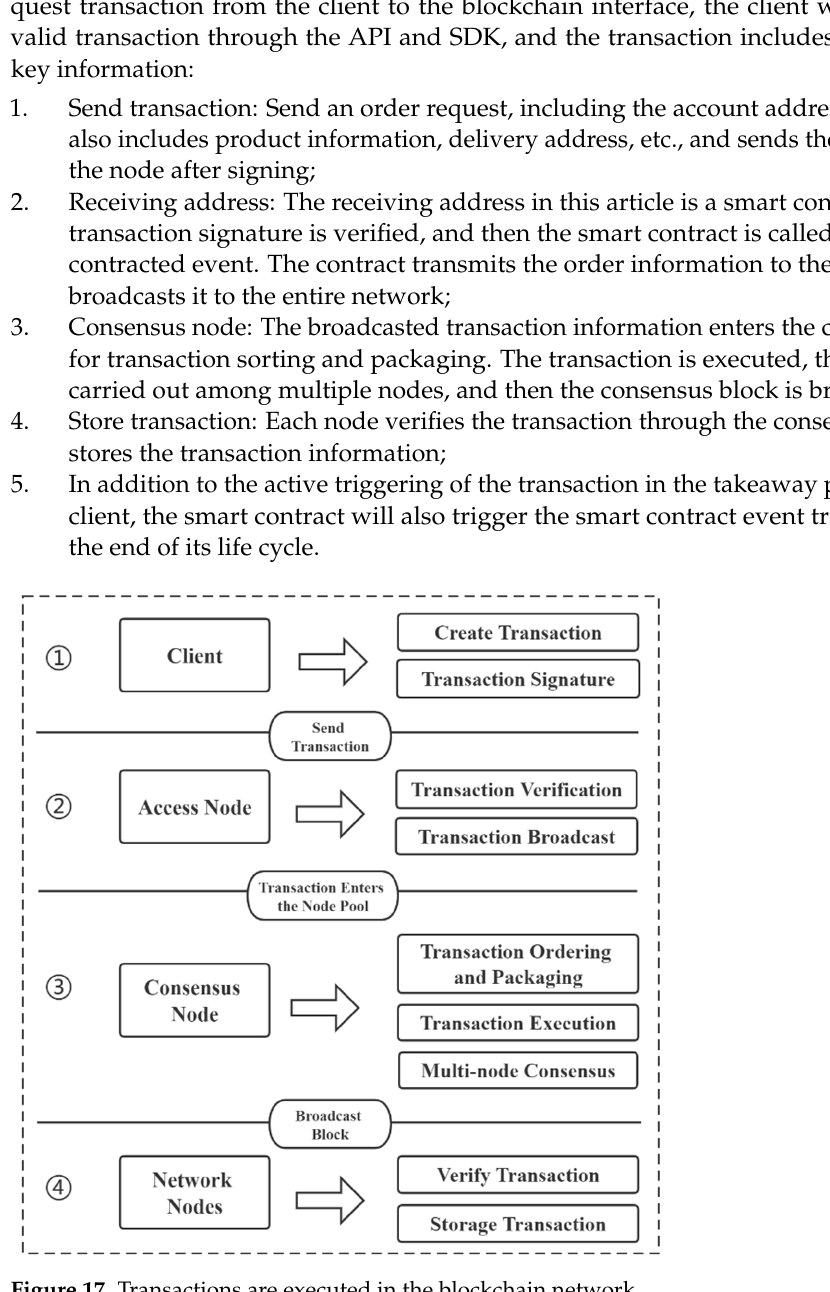
Figure 17. Transactions are executed in the blockchain network.